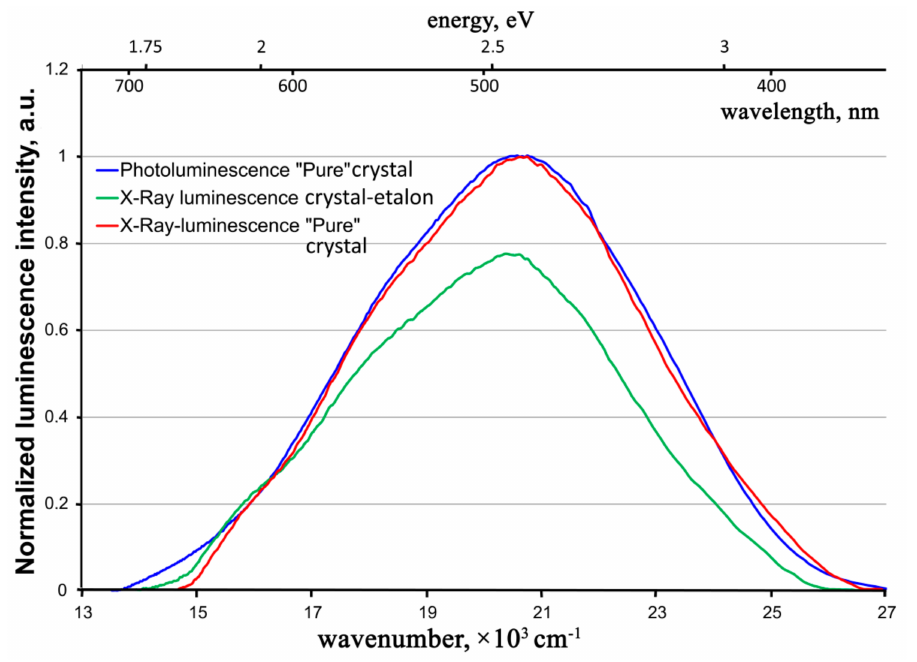
Figure 10. X-Ray luminescence spectra of the “pure” ZnWO 4 crystals in comparison with its photolu- minescence